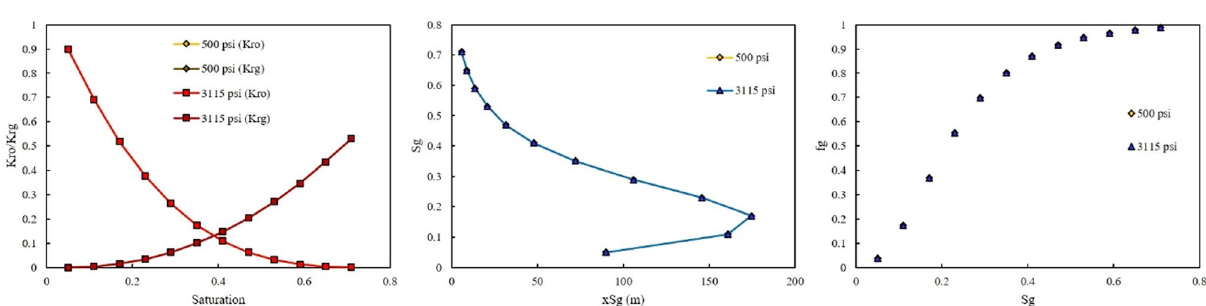
Figure 12. Effect of GOR of NGL on relative permeability, saturation profile, and fractional flow curve at an injection pressure of 3000 psi.